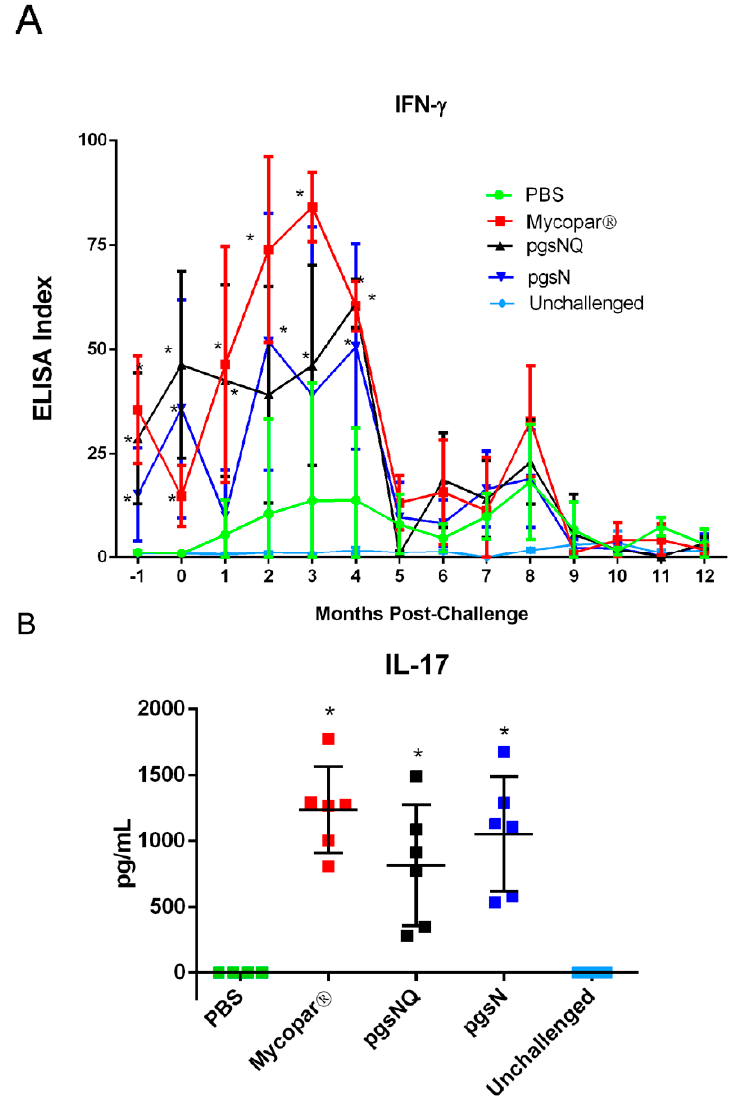
Figure 4. Blood levels of key cytokines in vaccinated calf groups. ( A ) IFN- γ response in calves before vaccination (0, − 1 month), post vaccination (1, 2 months) and post challenge (2–12 months). Peripheral blood mononuclear cells (PBMCs) were isolated from whole blood and stimulated with Johnin PPD for 72 h. IFN- γ levels in culture supernatants were determined using a Bovigam ELISA kit. Data are expressed as an ELISA index, with error bars representing the standard deviation; *, p < 0.05 compared to the PBS group. ( B ) IL-17 response in calves 2 months post vaccination. PBMCs were isolated from whole blood and stimulated with Johnin PPD for 72 h. IL-17 levels in culture supernatants were determined using an ELISA kit. Data are expressed as mean values with error bars representing the standard deviation; *, p < 0.05 compared to the PBS group.